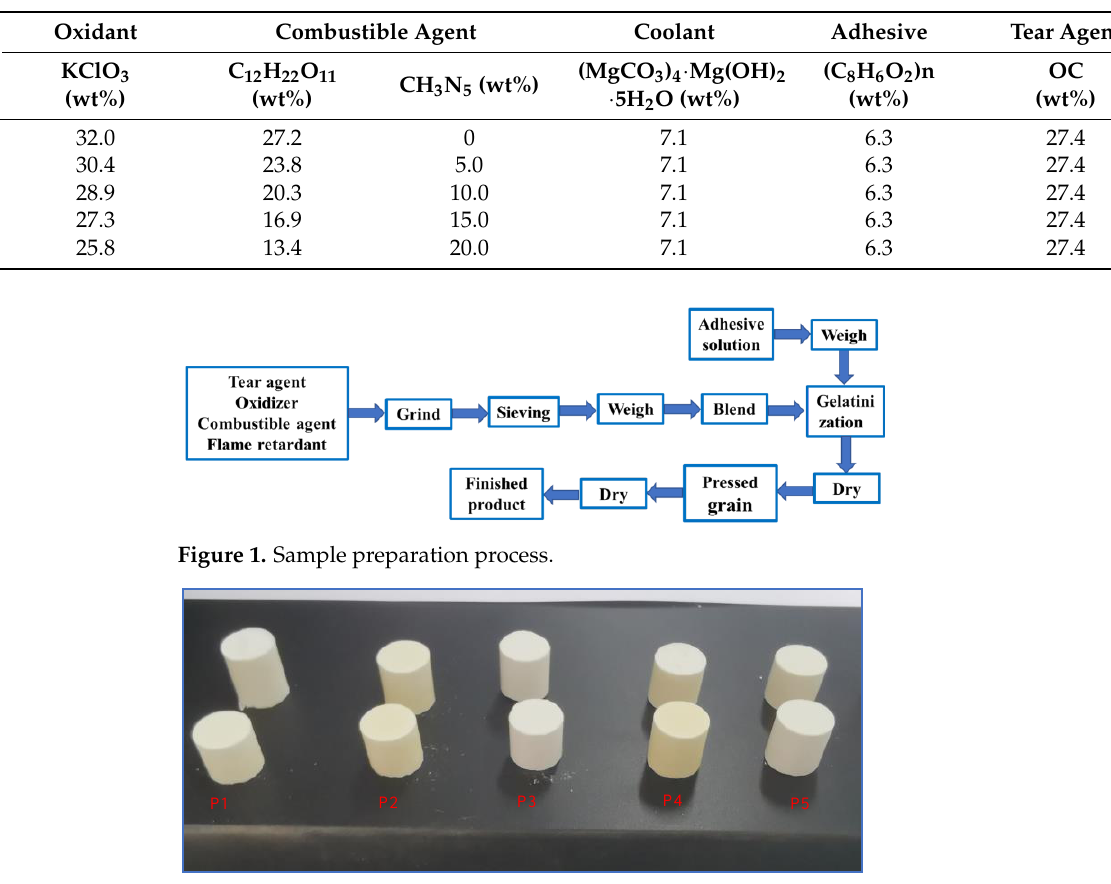
Figure 2. Tested samples with different formulations.